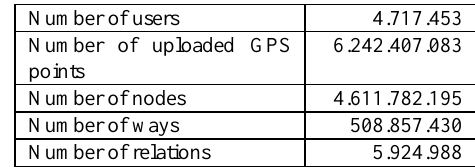
Table 2: Statistics of the